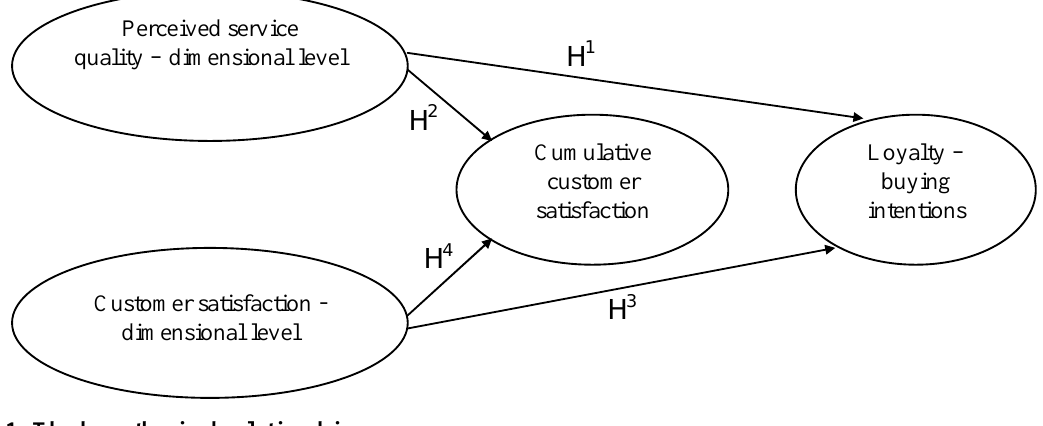
Figure 1: The hypothesised relationships